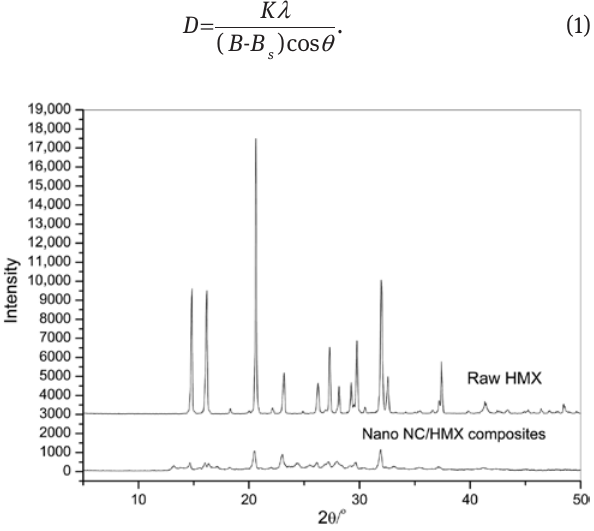
Figure 2: TEM images of nano NC/HMX composites at different magnification. Figure 3: XRD patterns of raw HMX and nano NC/HMX